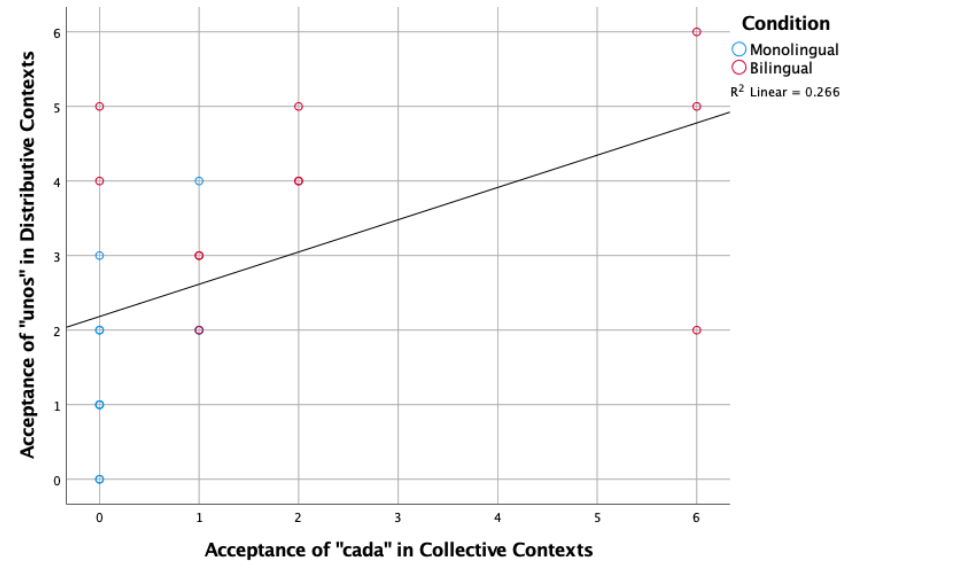
Figure 11. The Predictive Relationship of Acceptance of cada ‘each’ in Collective Contexts on the Acceptance of unos ‘some’ in Collective Contexts, in Bilingual and Monolingual